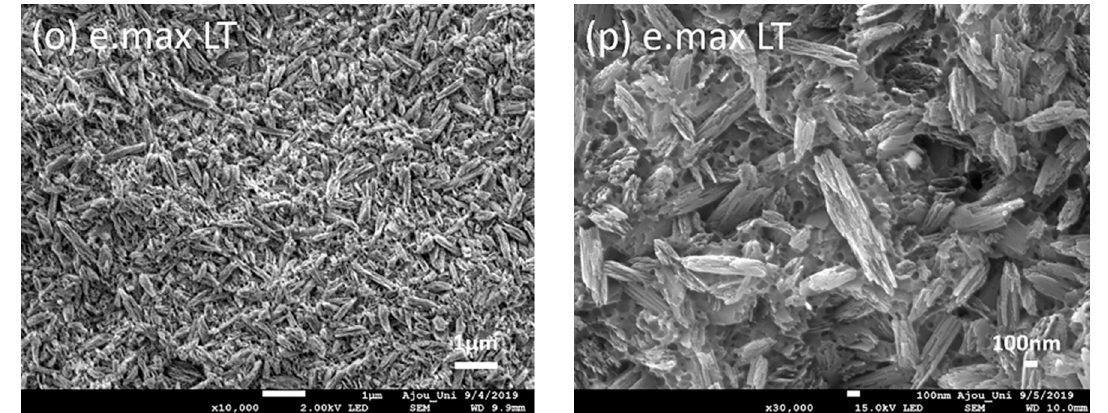
Figure 4. SEM images of ceramic specimens. 3Y-TZP: ( a ) LP (5000×), ( b ) LP (30,000×), ( c ) S2 (5000×), ( d ) S2 (30,000×); 5Y-PSZ: ( e ) LET (5000×), (f) LET (30,000×), ( g ) LEB (5000×), ( h ) LEB (30,000×), ( i ) BA (5000×), ( j ) BA (30,000×) ( k ) SMS2 (5000×), ( l )SMS2 (30,000×); Glass-ceramic: ( m ) e.max HT (10,000×), ( n ) e.max HT (30,000×), ( o ) e.max LT (10,000×), ( p ) e.max LT (30,000×). The micrographs of 3Y-TZP specimens depicted grain sizes that approached nanometric scales while 5Y-TZP specimens presented bigger grain sizes, approaching to micrometric scales. The black arrow ( j ) indicates the pore; the red circle ( h ) indicates a tetragonal grain; the black circle ( h ) indicates a cubic grain of zirconia. According to XRF analysis, the erbium (Er) rare-earth metal was identified in LET, LEB, and SMS2. As trace elements, aluminum (Al), iron (Fe), and calcium (Ca) ions were detected for zirconia. Al was detected in LP (0.06 wt.%), S2 (0.05 wt.%), LET / LEB (0.03 wt.%), and SMS2 (0.02 wt.%). Fe was found